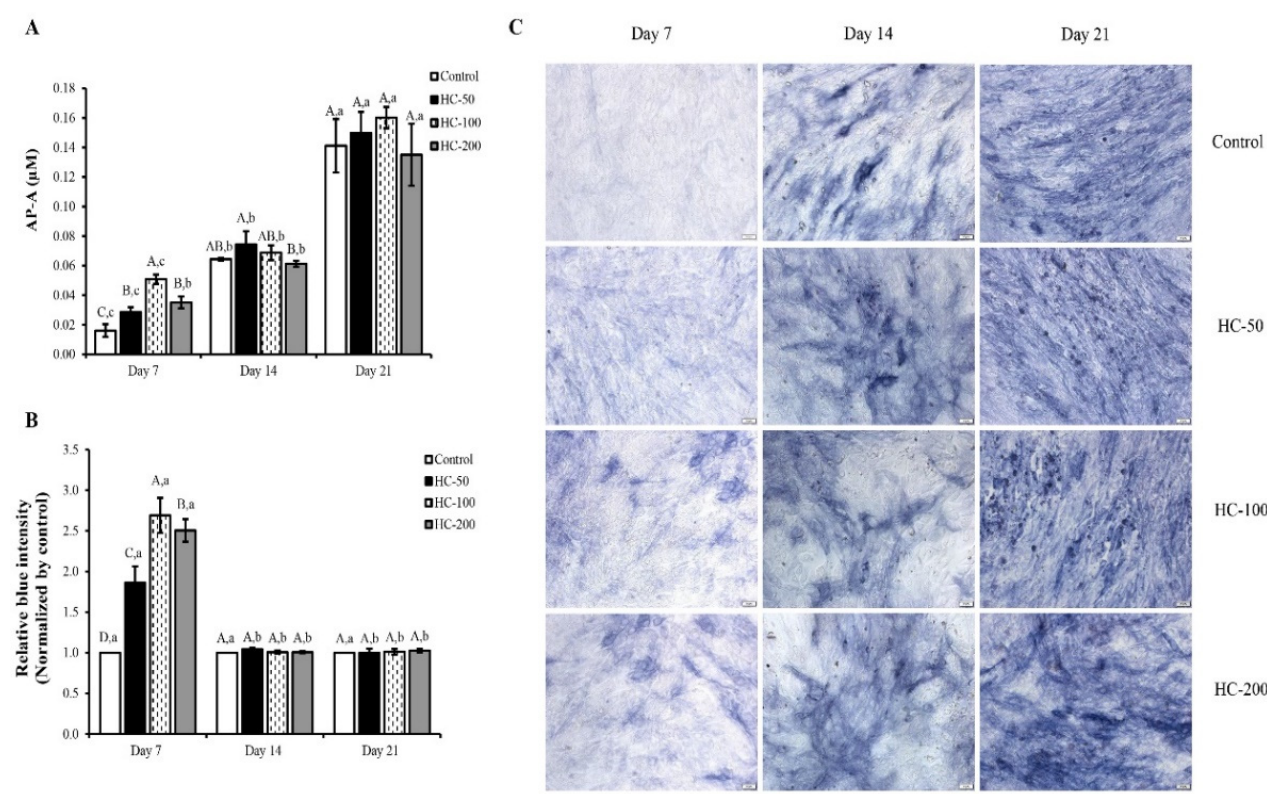
Figure 3. Effect of defatted sea bass skin hydrolyzed collagen (HC) on ( A ) alkaline phosphatase activity (AP-A) of MC3T3-E1 cells, ( B ) relative blue intensity of alkaline phosphatase and ( C ) blue crystal staining intensity (scale bar = 100 µm; magnification = ×10) at different culture times. Quantitative analysis of blue intensity was assessed using ImageJ software. Error bars represent standard deviation ( n = 3). Different uppercase letters indicate significant differences between samples at the same culture time ( p < 0.05). Different lowercase letters indicate significant differences between culture times of the same sample ( p < 0.05).